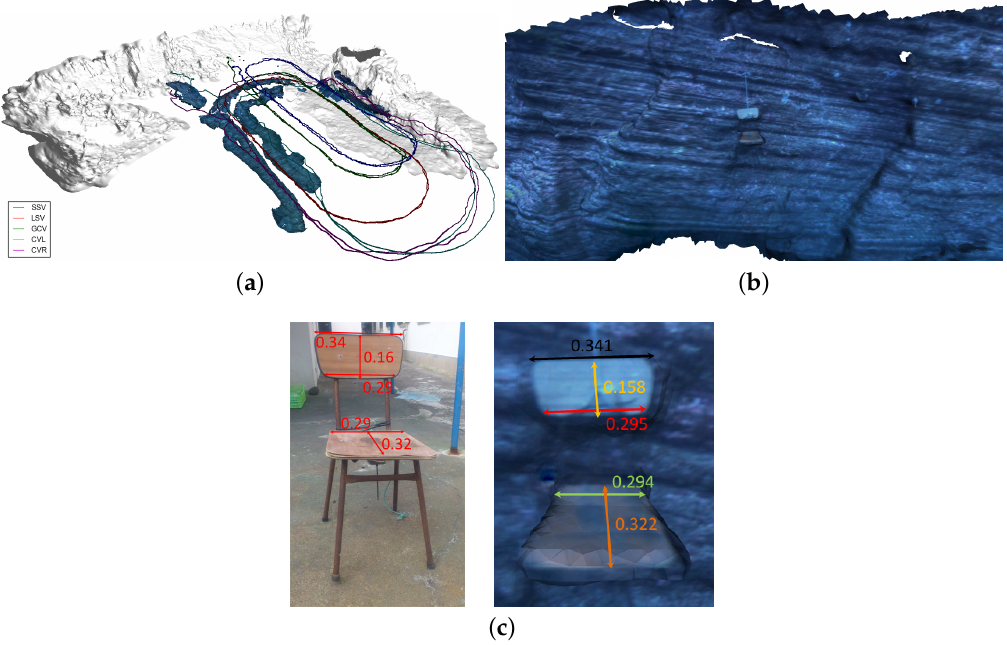
Figure 9. Optical reconstruction for the Morph Horta dataset from the 9th of September 2015. We show the final reconstructed textured model with the optimized trajectories, along with the global bathymetric map for reference in ( a ). Also, we give a close-up view of the reconstructed wall in ( b ), and we compare real-world measurements taken on the ground truth object (the chair) with some taken on the reconstructed model in ( c ).